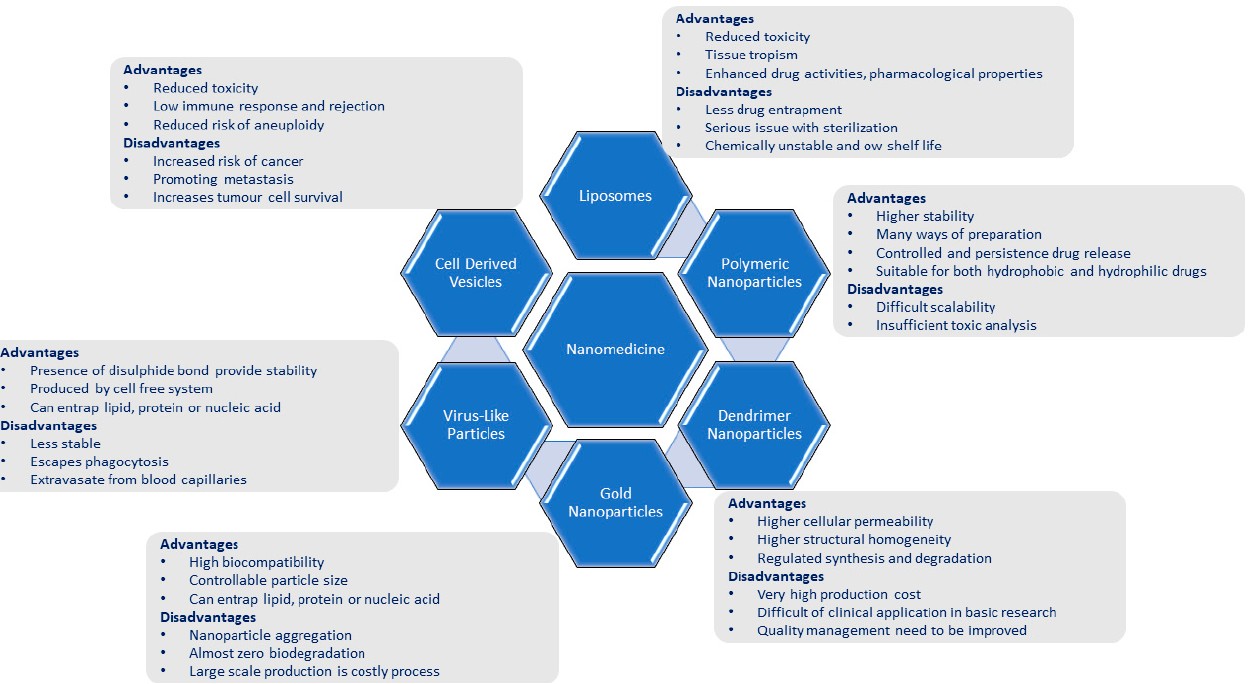
Figure 5. Advantages and disadvantages of the different types of nanomedicines. Table 1. Merits and demerits of nanoparticle-based COVID-19 vaccines.